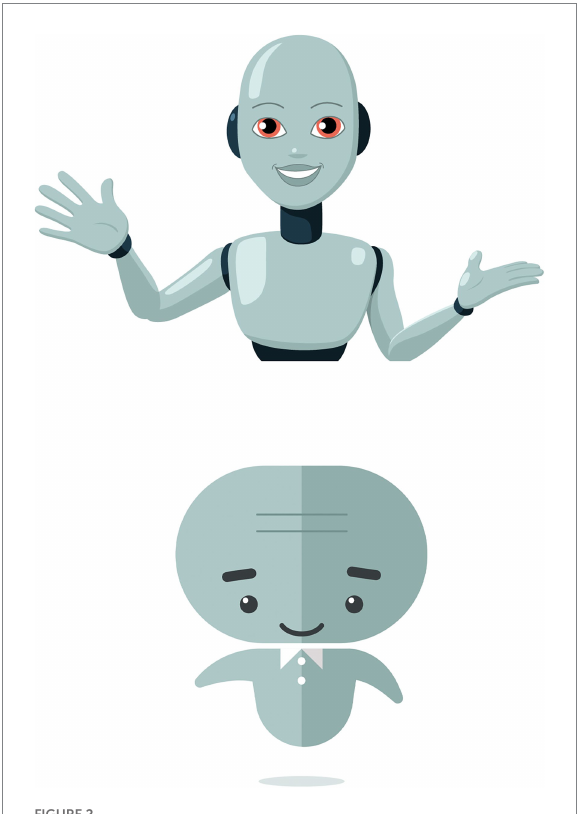
FIGURE 2 First version (top) and second version (bottom) of